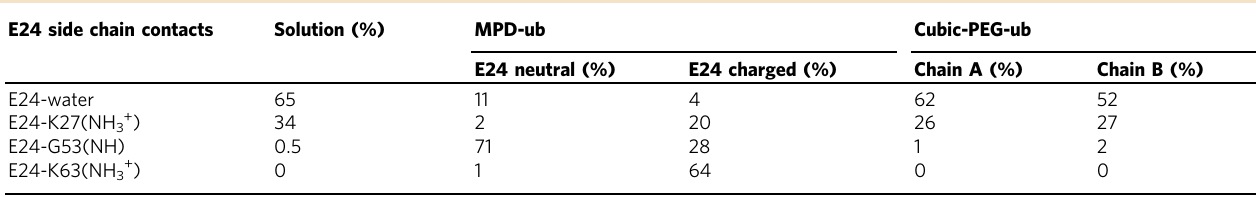
Table 2 Important interactions involving E24 side-chain carboxylic group as characterized by their presence in the MD simulations